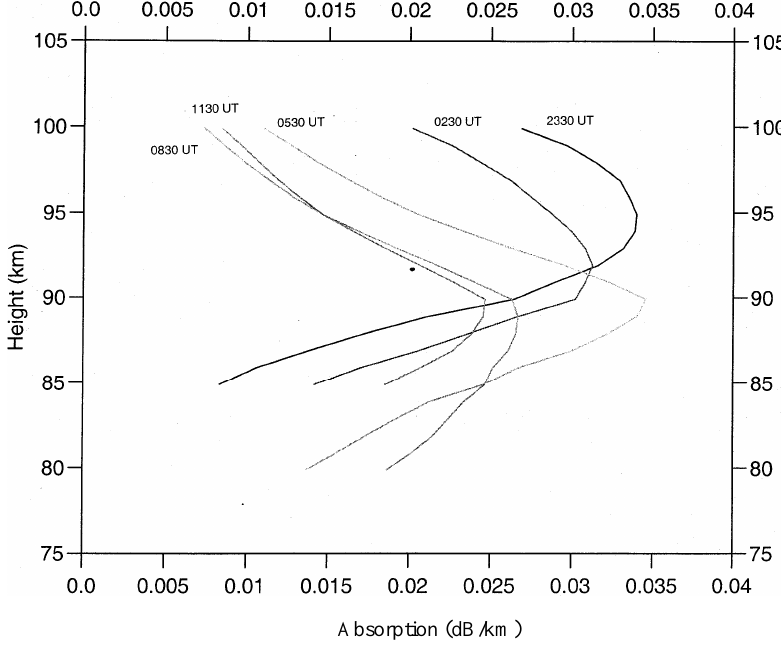
Absorption (dB/km)